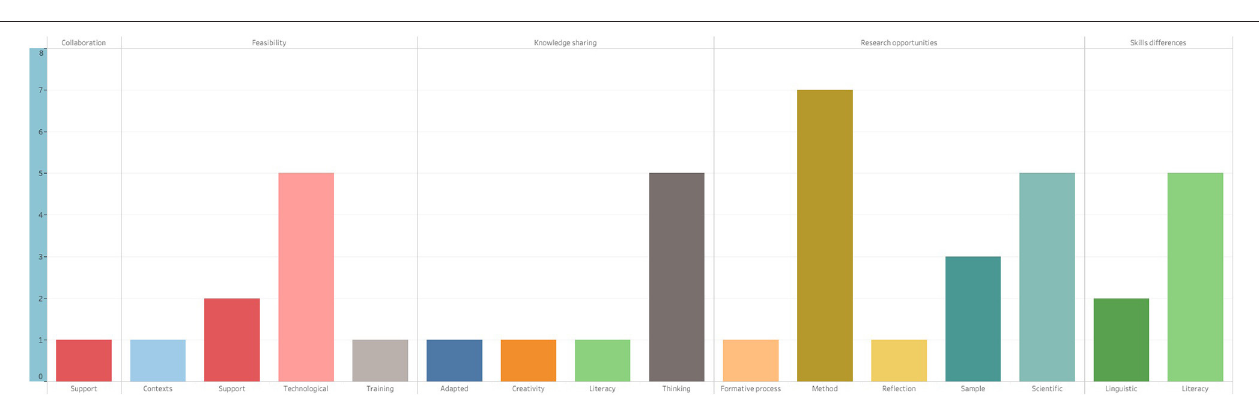
FIGURE 7 | Research challenges for the research skills and academic reading and writing